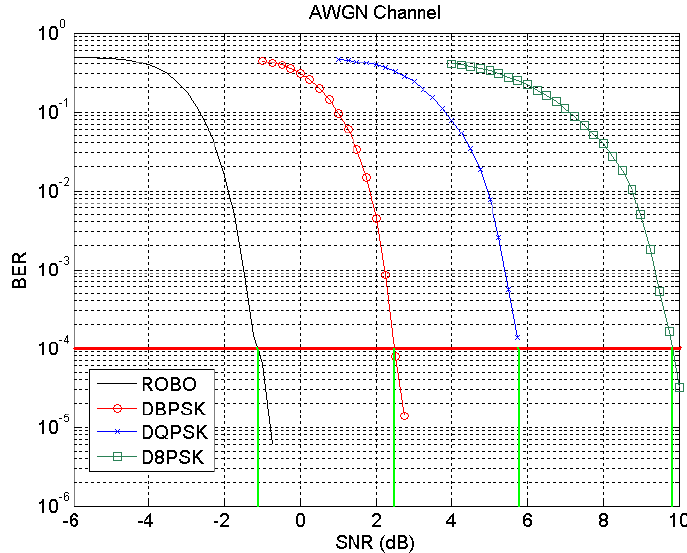
Figure 17. Reliability of the G1-PLC and the G3-PLC technologies: source G3-PLC TM Alliance [38].